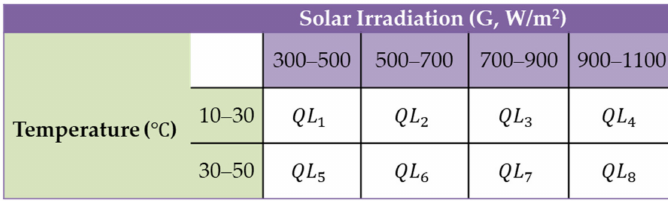
Figure 16. Control zones of the PV system based on the Q–learning algorithm.